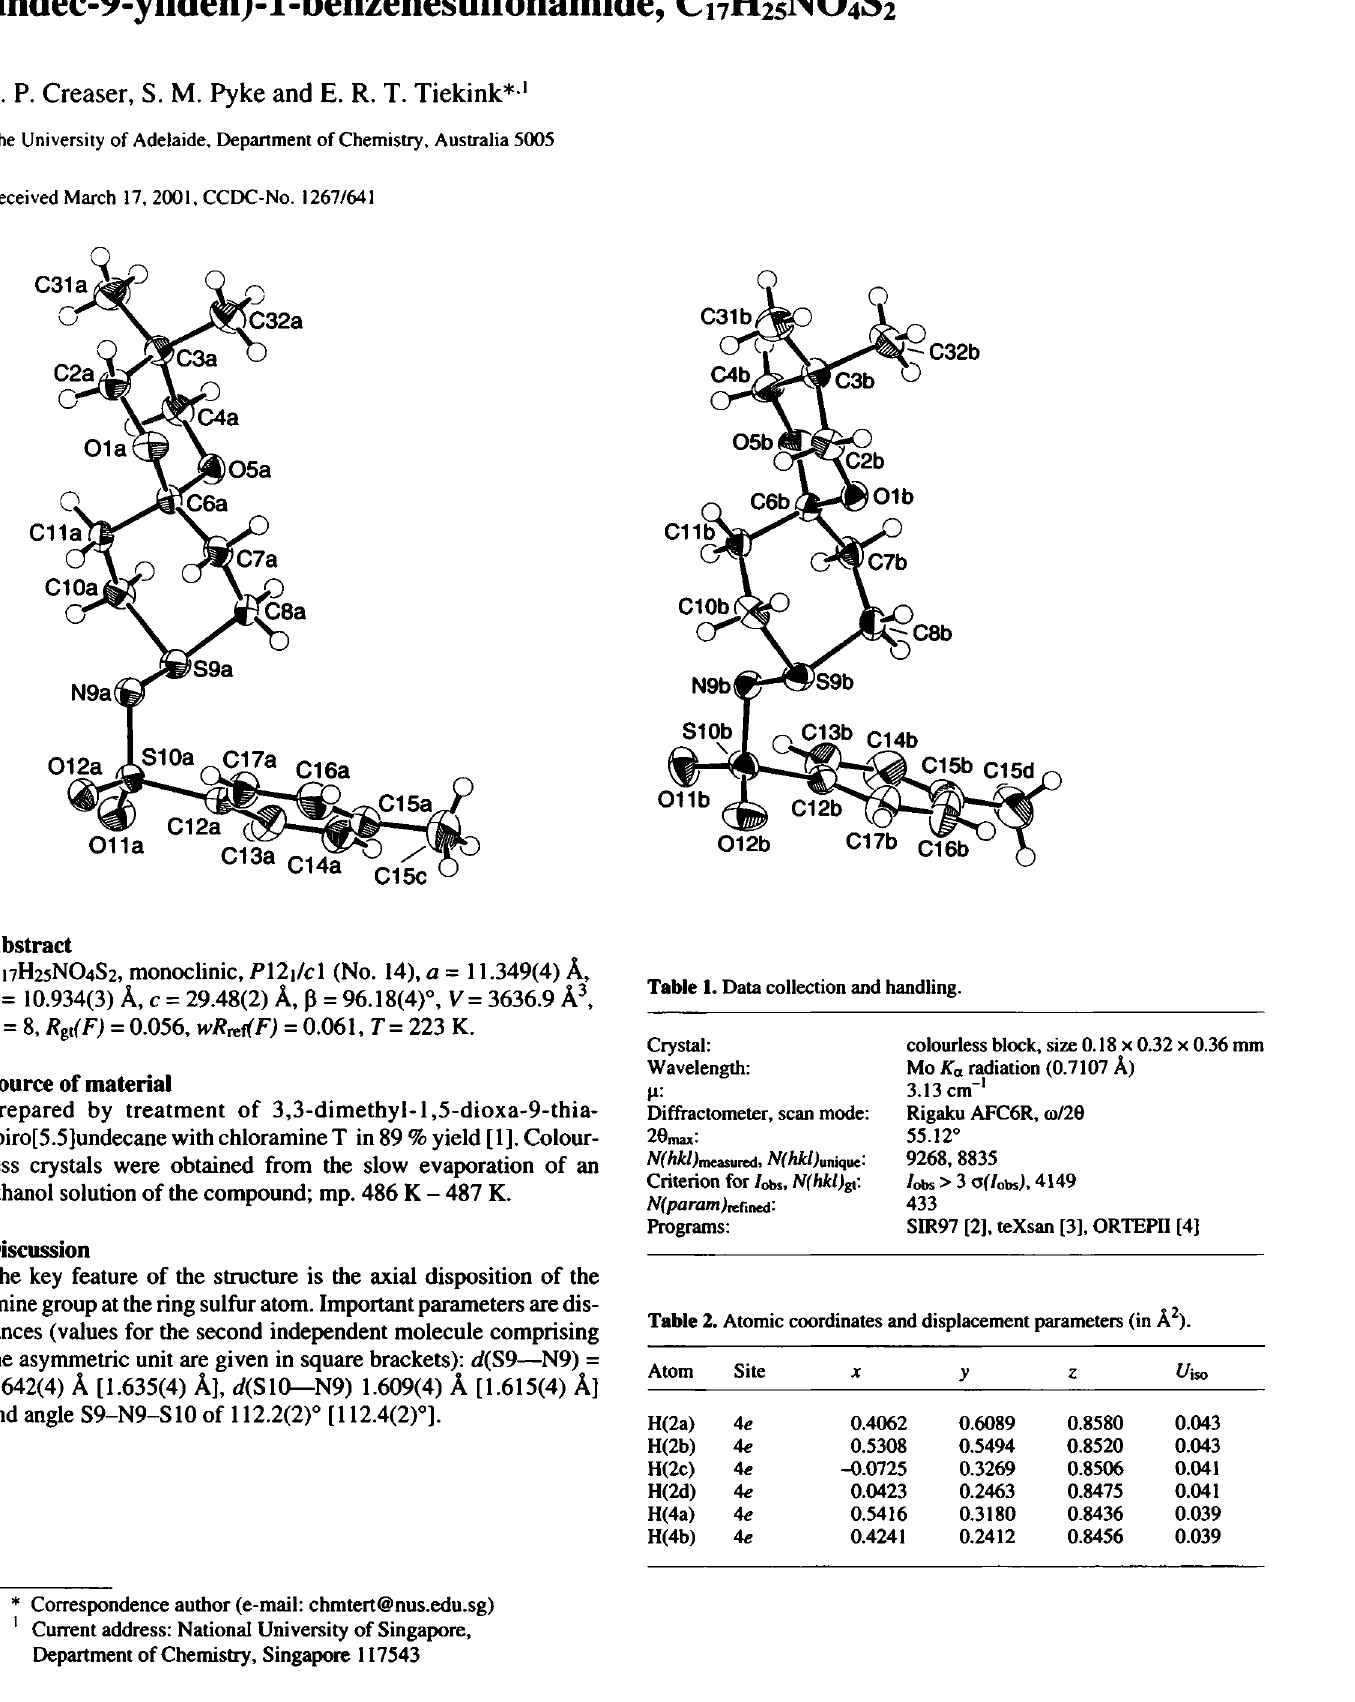
Table 1. Data collection and handling.